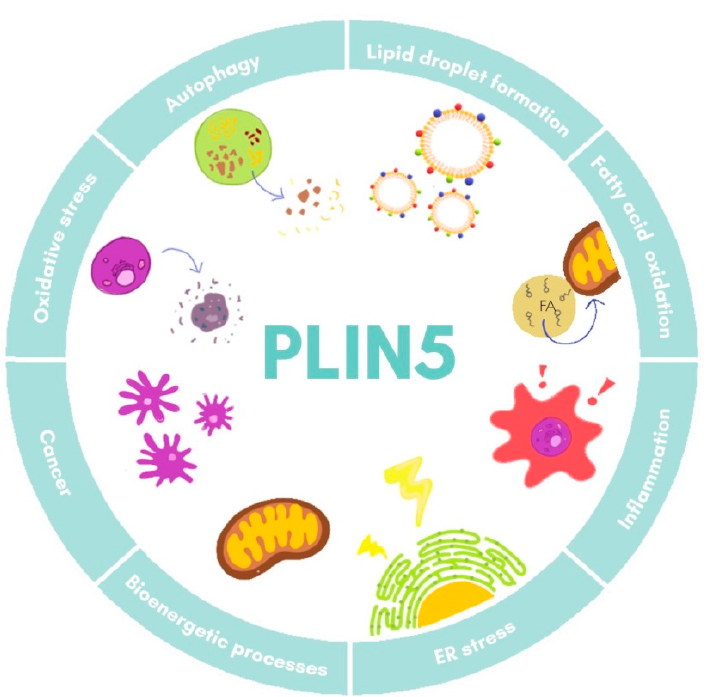
Figure 3. Cellular functions of PLIN5. Major processes in which PLIN5 has been reported to participate are shown. ER, endoplasmic reticulum .